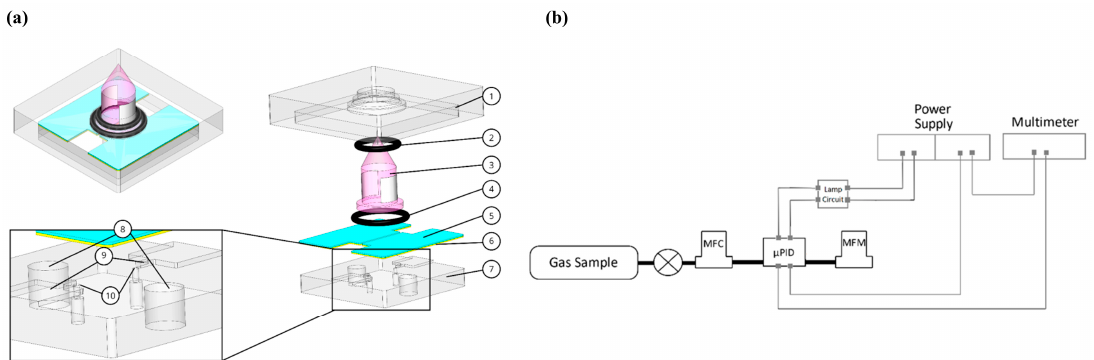
Figure 13. Device architecture and schematic of the different components. ( a ) Assembled and exploded view of the detector core. (1) Top poly(methyl methacrylate) (PMMA), (2) O-ring 1, (3) UV lamp, (4) O-ring 2, (5) shield, (6) copper electrodes, (7) bottom PMMA, (8) electrode connection holes, (9) elevation structure, (10) micro-pores. ( b ) Experimental setup used for signal measurements from µPID prototype. Reproduced with permission under the terms of the CC BY 4.0 license from [12] Copyright 2019, the authors, published by MDPI.